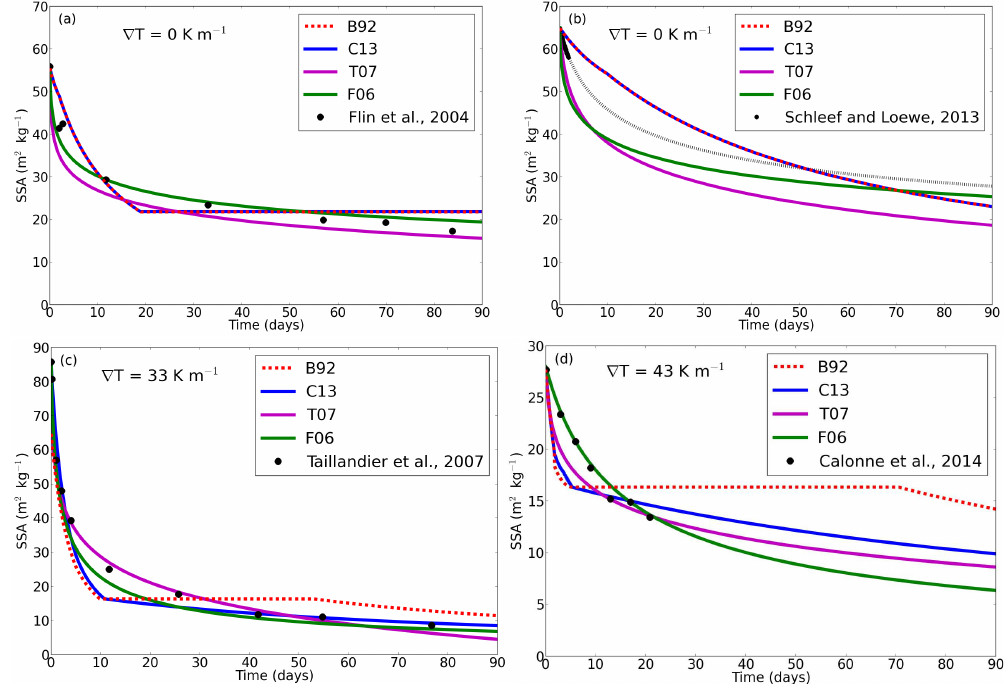
Fig. 4. Comparison between the SSA rate of decay predicted by different metamorphism formulations and measured during cold room experiments. The isothermal experiments of Flin et al. (2004) and Schleef and Loewe (2013) were performed at T =− 2 ◦ C and T =− 20 ◦ C, respectively. In the temperature gradient experiment of Taillandier et al. (2007), ∇ T was 33Km − 1 and the temperature was − 10 ◦ C. These values were respectively 43Km − 1 and − 4 ◦ C for the temperature gradient experiment of Calonne et al. (2014). In (b) , we plotted both the data (black dots) and the fit (black dotted line) according to Eq. (7) of Schleef and Loewe (2013).